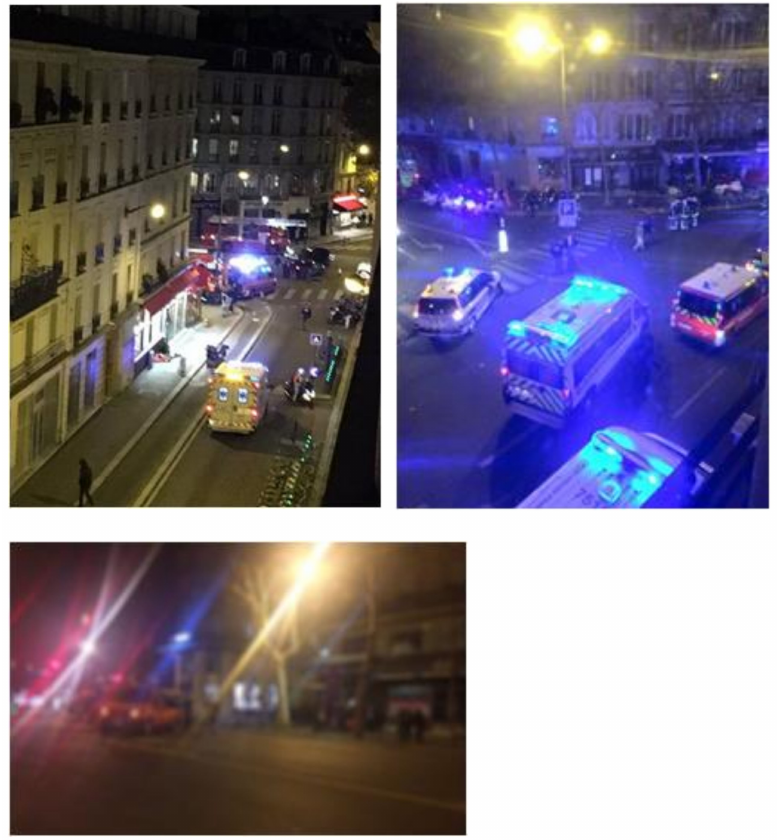
Figure 15. An example of images retrieved from Twitter during terrorists’ attacks which have not been correctly matched by the ASMIS system due to low quality.